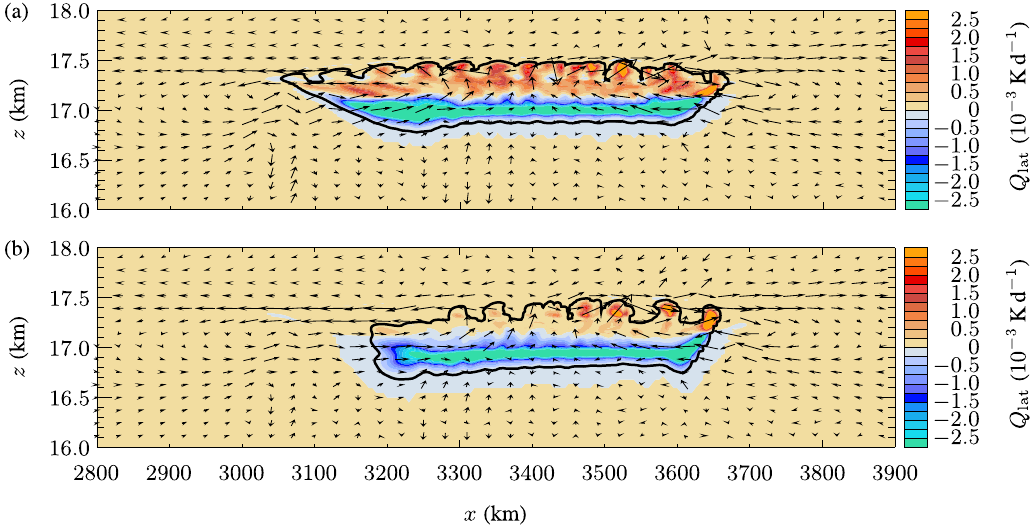
Fig. 12. Instantaneous latent heat release at 3 . 5d in the all-physics case (a) and in the no-RAV case (b) . The thick, black contour marks the cloud boundary, which is defined by the 1l − 1 contour of ice number concentration. Vectors show the radiatively induced